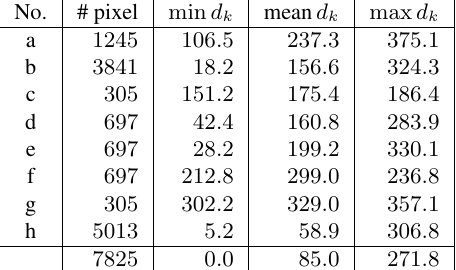
Table 2. Values of d k for pixels at manually labelled specular re- flections. The last row below the line does not refer to a specular reflection, but to a direct view into the